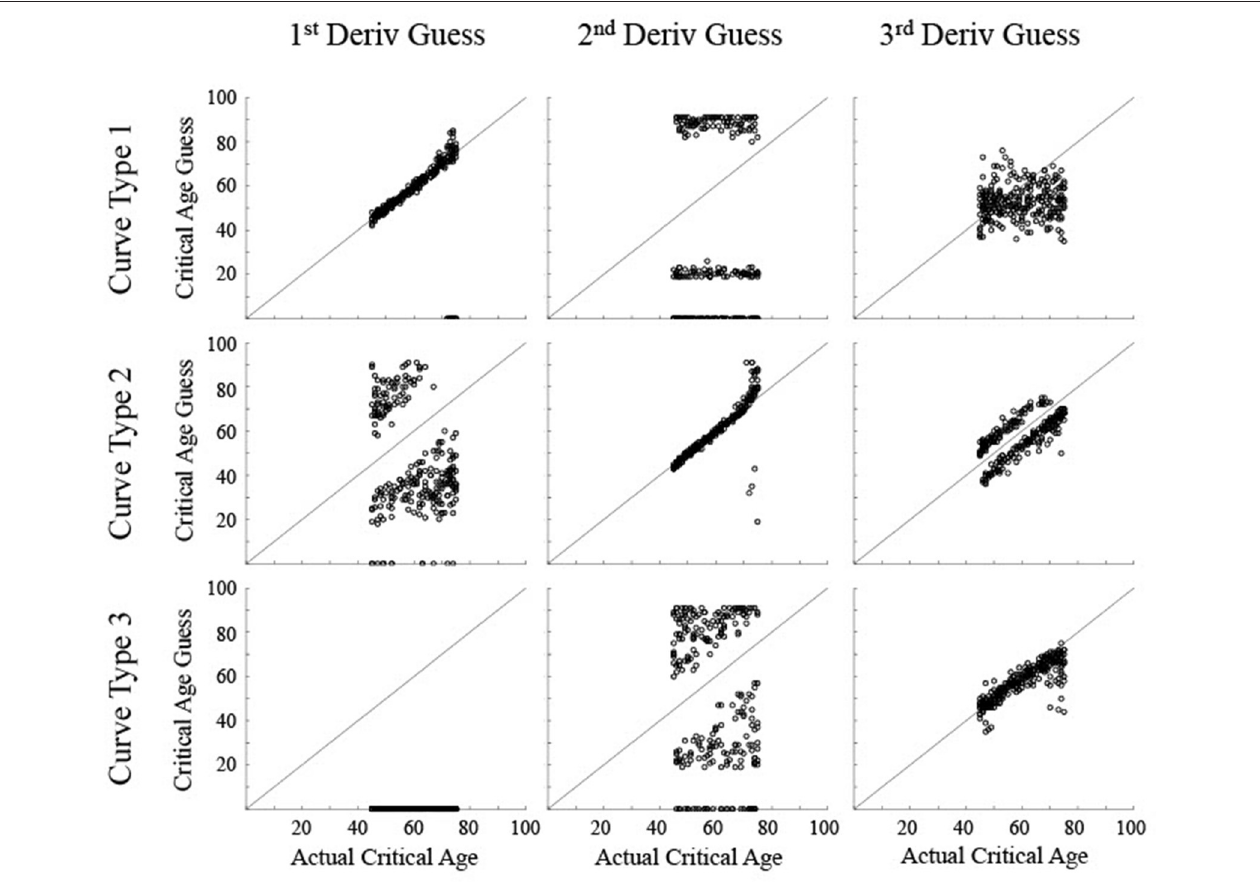
FIGURE 6 | Scatter plots show the critical age guesses for the Realistic Noise data ( σ the diagonal line indicate a match between the calculated critical age and the actual critical age of the stimulated data. Points along the x-axis indicate no derivative zero points for that